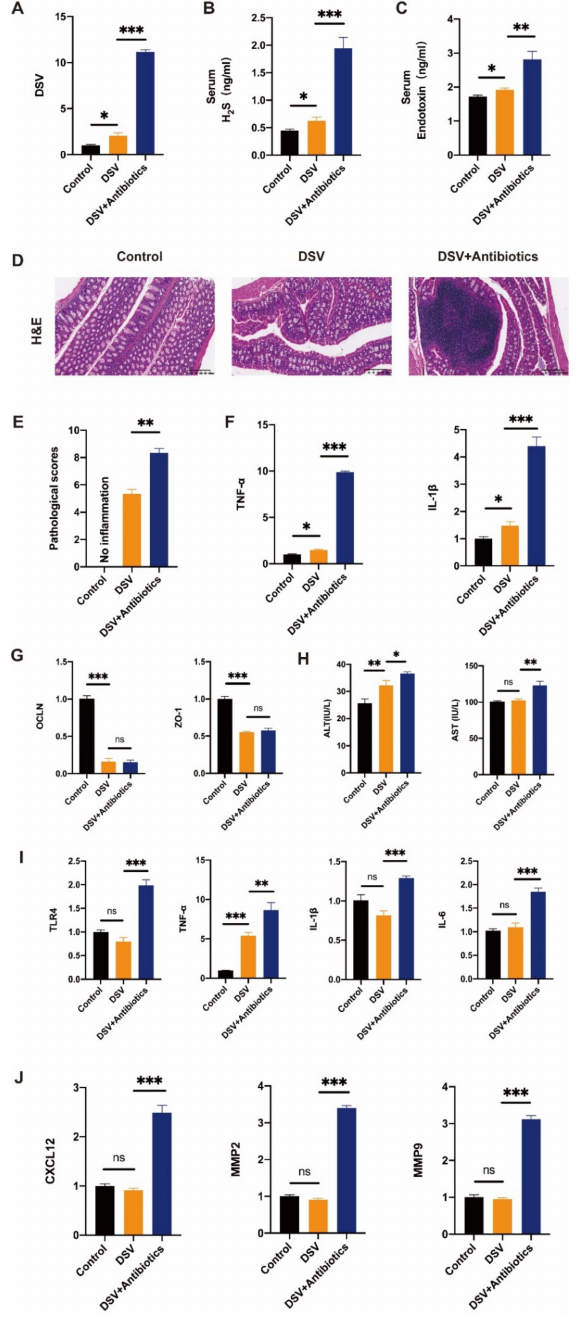
Figure 6. Oral gavage of DSV could exert an effect on the colon and liver and engage in the construction of metastasis microenvironment in mice. ( A ) The colonization of Desulfovibrio in the colon of different groups detected by qPCR. ( B ) The level of serum H 2 S in mice was evaluated by an H 2 S production assay. ( C ) The level of serum endotoxin in mice was evaluated by serum endotoxin production assay. ( D ) Haematoxylin and eosin staining of colon tissue sections collected from mice treated as above. ( E ) HE is calculated histopathological scores. ( F , G ) mRNA expression of IL-1 β , TNF- α , ZO-1, and OCLN in intestinal mucosa are shown as relative fold to control normalized to GAPDH. ( H ) Levels of serum ALT and AST in mice at eight weeks of administration. ( I ) mRNA expression of TLR4, TNF- α , IL-1 β , IL-6 are shown as relative fold to control normalized to GAPDH. ( J ) mRNA expression of MMP9, MMP2, and CXCL12 are shown as relative fold to control normalized to GAPDH. Data represent means ± SEM. * p < 0.05; ** p < 0.01; *** p < 0.001, ns: no significant. (Control, n = 7; DSV, n = 7; DSV+Antibiotics, n =